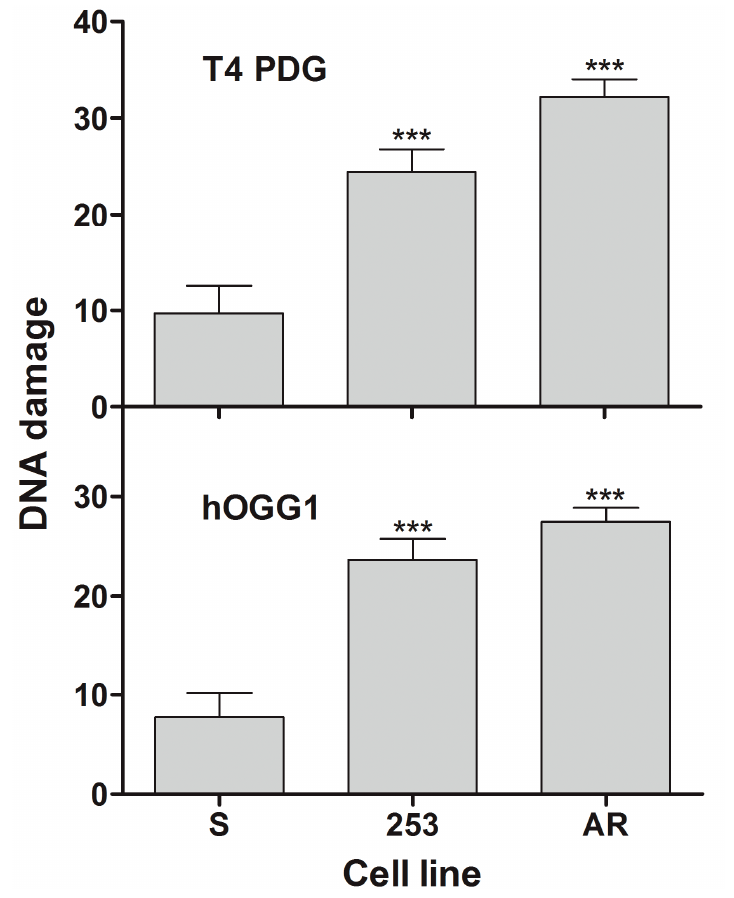
Figure 3. Mean DNA damage measured by percentage of DNA in tail of comets in alkaline version of comet assay modified by the use of T4 pyrimidine dimer glycosylase (T4 PDG) and human 8-oxoG glycosylase (hOGG1) in mouse 32D cells transfected with the BCR-ABL1 gene: sensitive (S) and resistant to imatinib exposed to UV radiation at 35 J/m 2 at room temperature at a dose rate of 0.12 J/(m 2 ·s). Imatinib resistance resulted from the Y253H mutation in BCR-ABL1 (253) or from incubation of S cells with escalating doses of imatinib (AR). Presented are means of three independent measurements, each for 100 cells; error bars represent SEM; *** p < 0.001 as compared with S